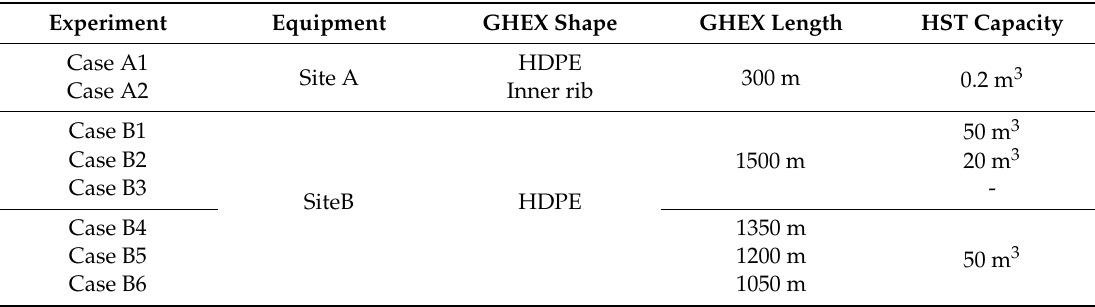
Table 2. Case conditions. GHEX: ground heat exchanger, HST: heat storage